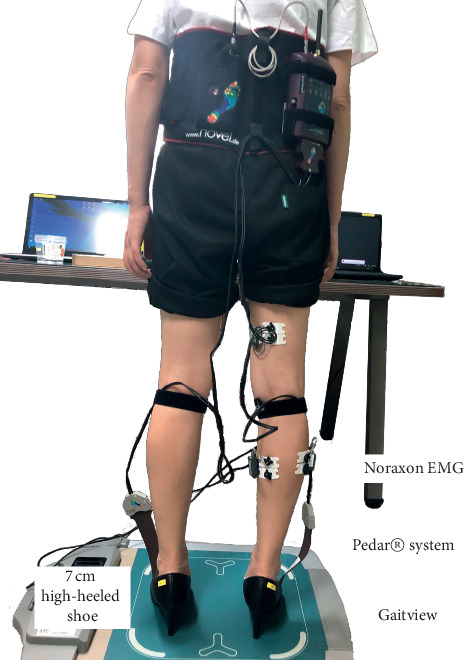
Experimental setup.